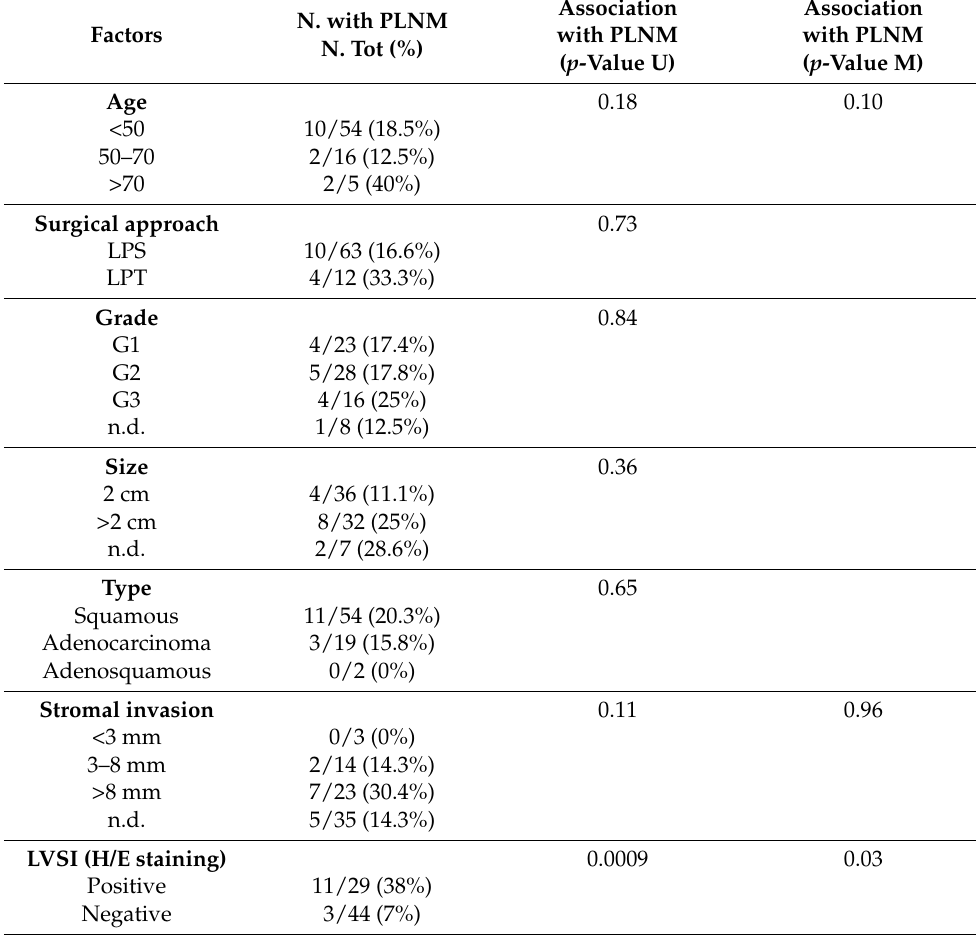
Table 2. Risk factors associated with PLNM.